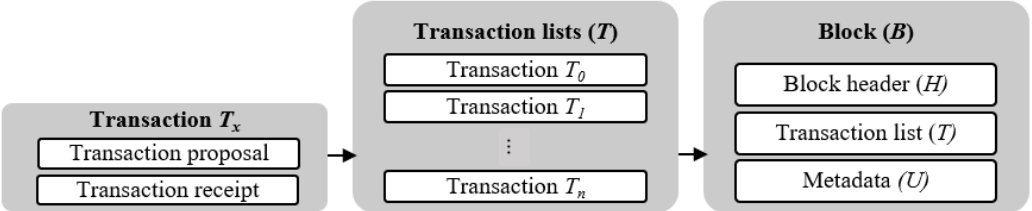
Figure 2. Simplified illustration of blocks and transactions.